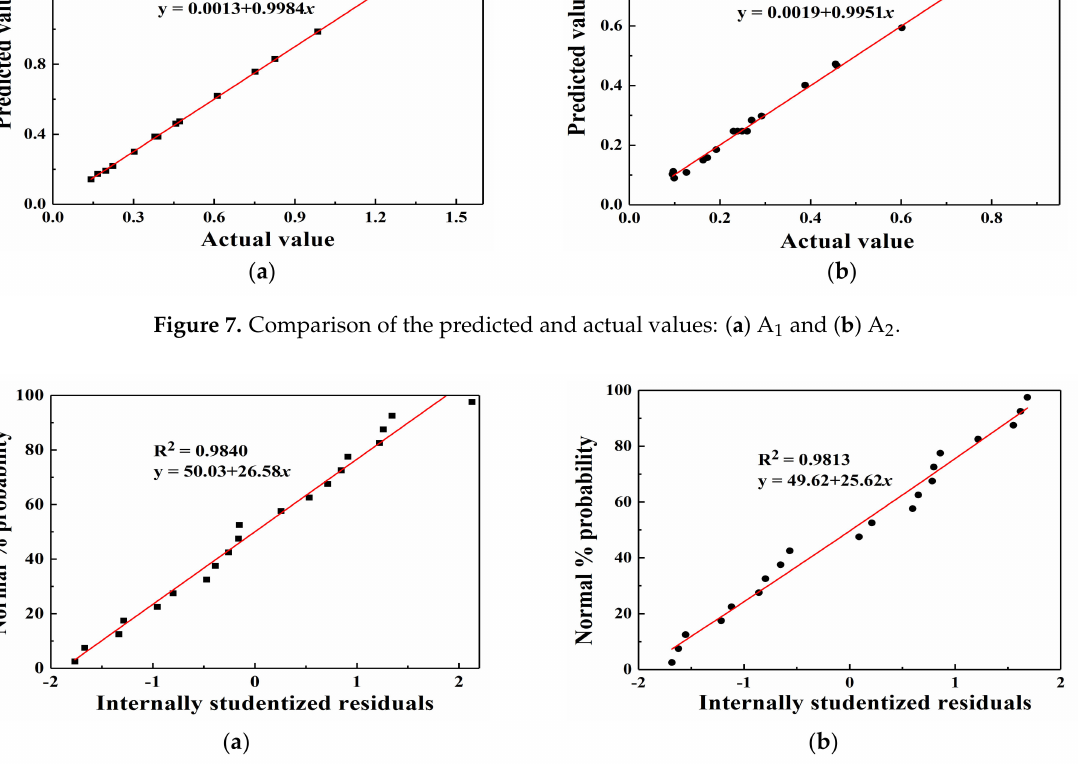
Figure 8. Normal probability distribution of the residuals: ( a ) A 1 and ( b ) A 2 .